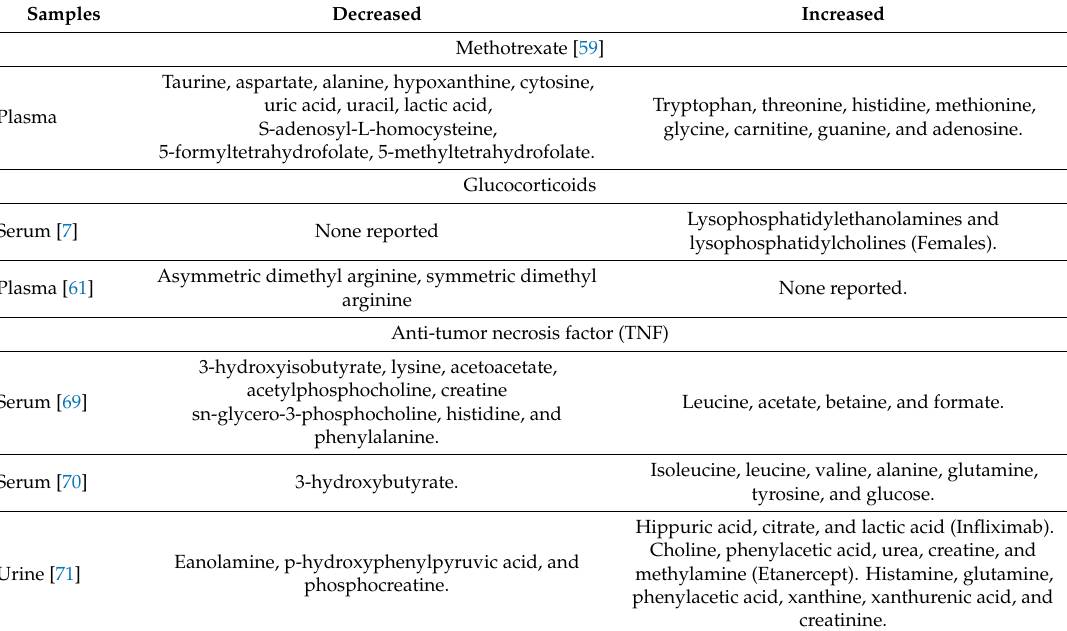
Table 3. Metabolic profile modifications by drugs used in the treatment of